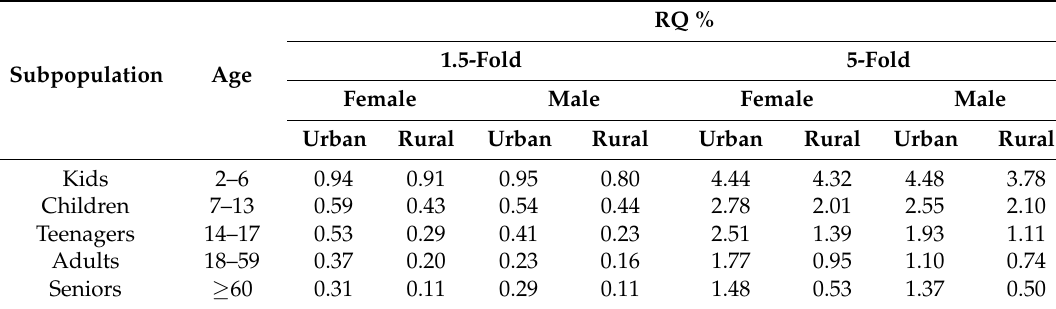
Table 4. Dietary intake risk assessment of cyflumetofen in whole